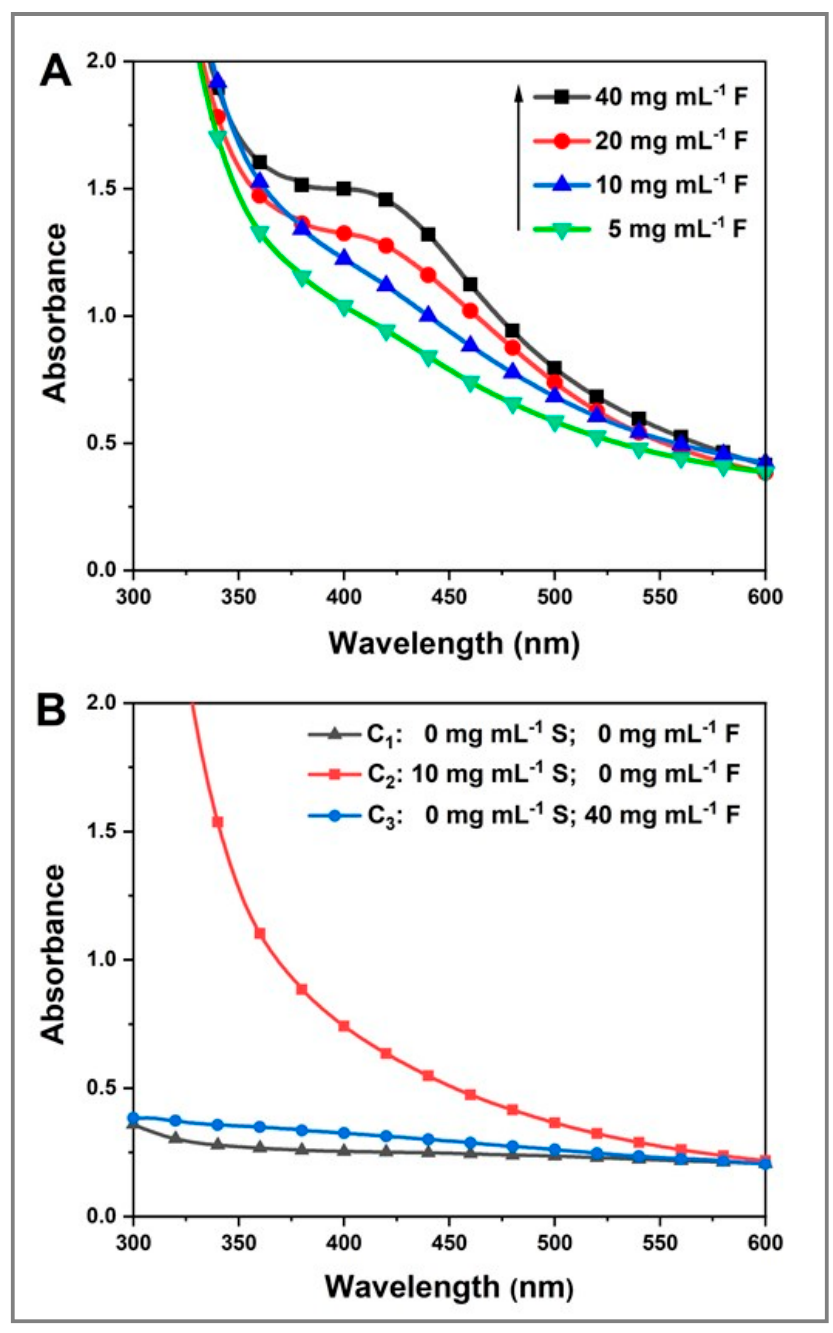
Figure 2. UV–Vis spectra of the as-synthesized Ag 2 Se NPs; ( A ) at different fructose concentrations and a constant starch concentration of 10 mg mL − 1 ; and ( B ) control experiments. F: fructose; S: starch.